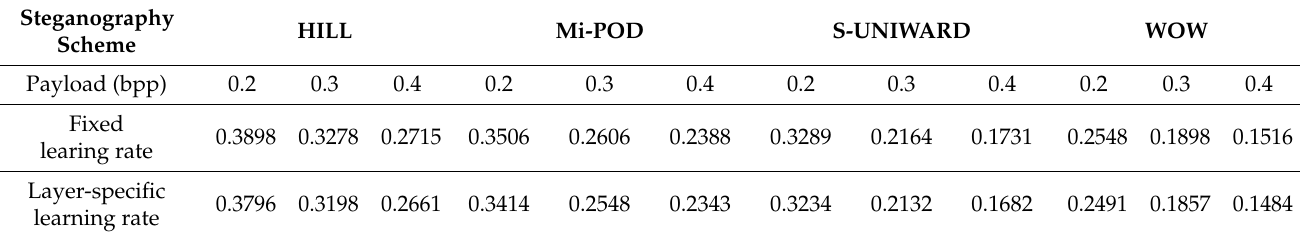
Table 3. Detection errors of fixed and layer-specific learning